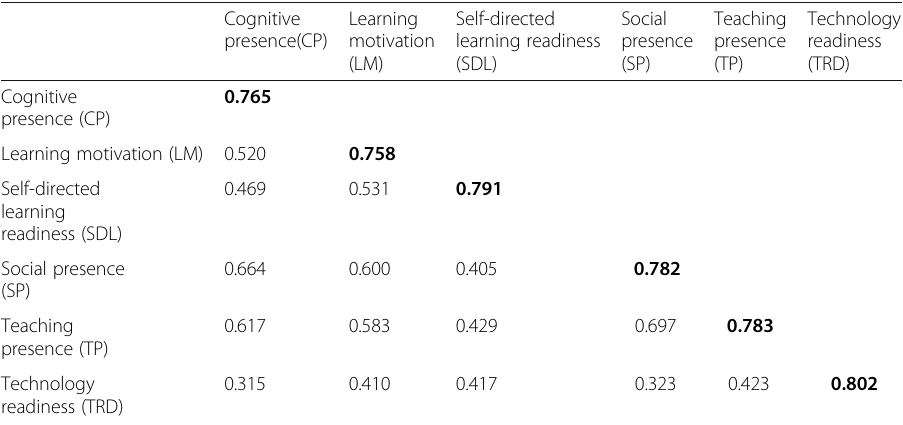
Table 3 Correlation between constructs